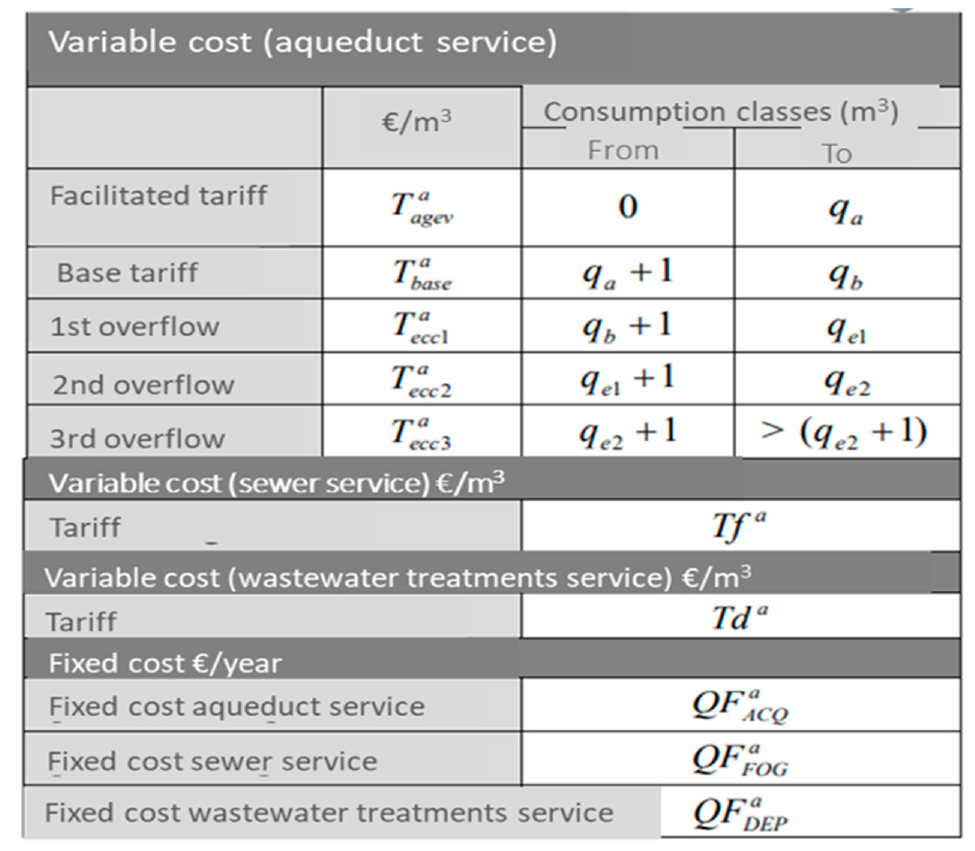
Figure 1. Binomial structure of water tariff by ARERA Resolution 665/2017/R/idr (Integrated Text on Water Services Tariffs-TICSI).